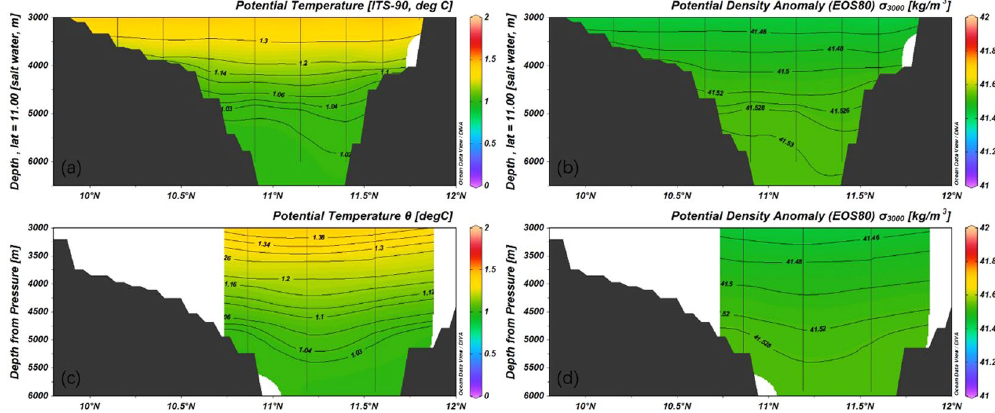
Figure 5. Potential temperature and potential density. ( a ) Potential temperature along the transect of 141.5°E during 2016S2, ( b ) potential density along the transect of 141.5°E during 2016S2, ( c ) potential temperature along the transect of 142°E during 2016S1, ( d ) potential density along the transect of 142°E during 2016S1. These were generated using ODV.